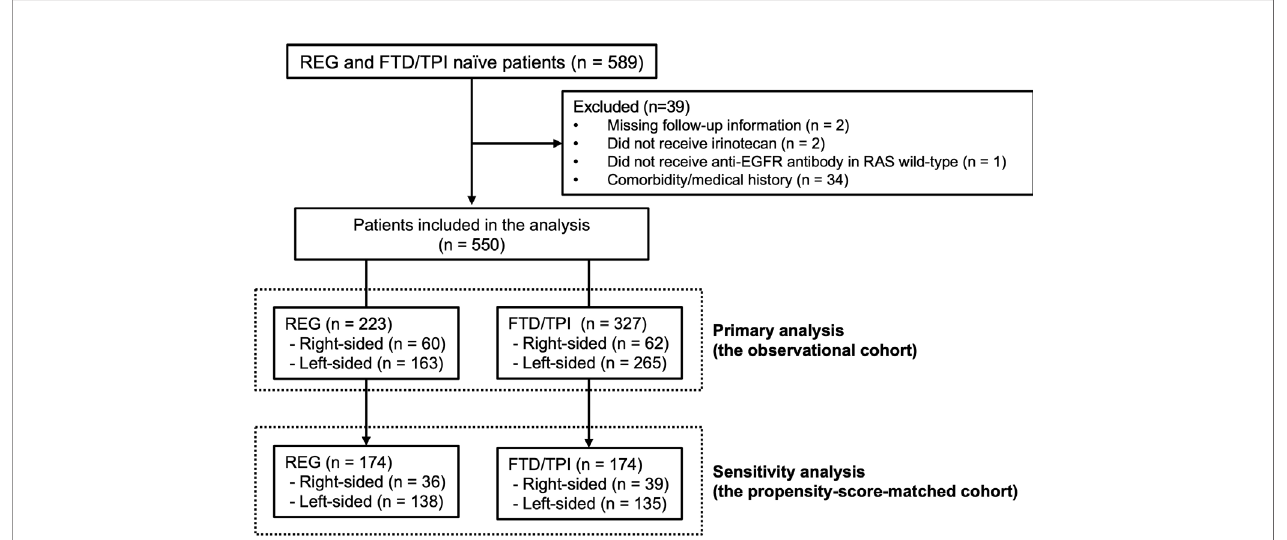
FIGURE 1 | Patient selection fl ow